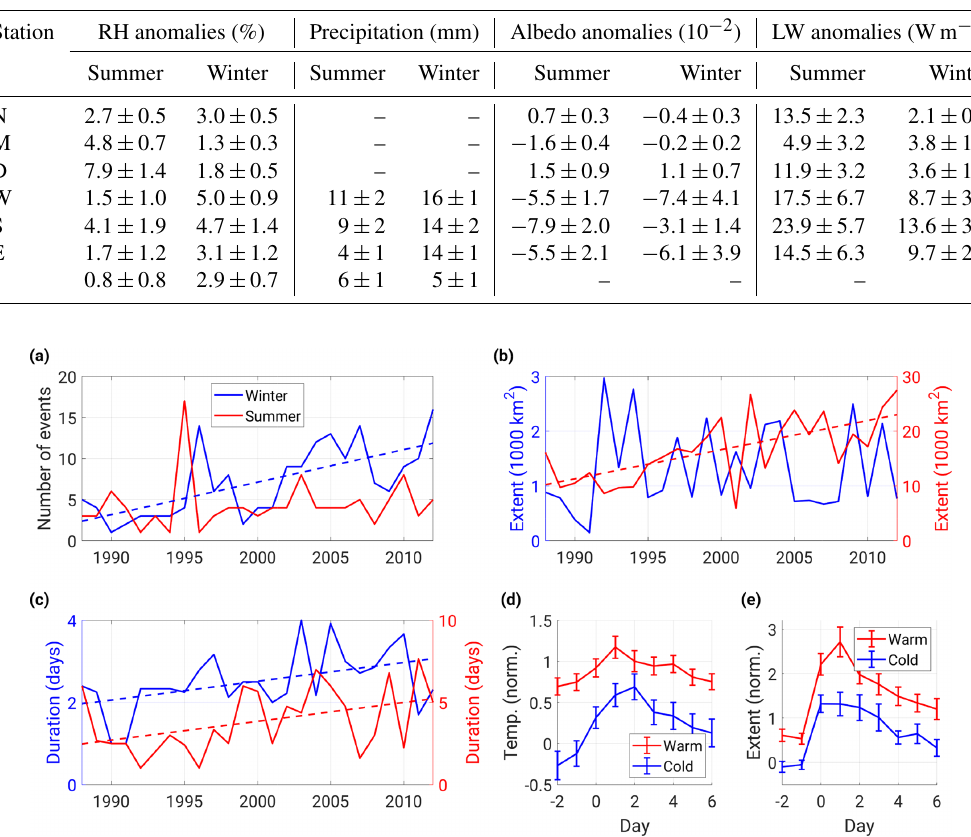
Figure 6. Variability of (a) the occurrence, (b) the melt extent, averaged from day 0 to 2, and (c) the duration of melt events in winter and summer, where winters are assigned to the year in which they end. Composites of the normalized (d) temperature and (e) melt extent evolution at Station West for the melt events in the five warmest and coldest summers and winters (averaged). This results in 53 (18) events in the warm (cold) winters and 27 (15) events in the warm (cold) summers. Normalized implies that the mean annual cycle has been subtracted and the result has been divided by the standard deviation.